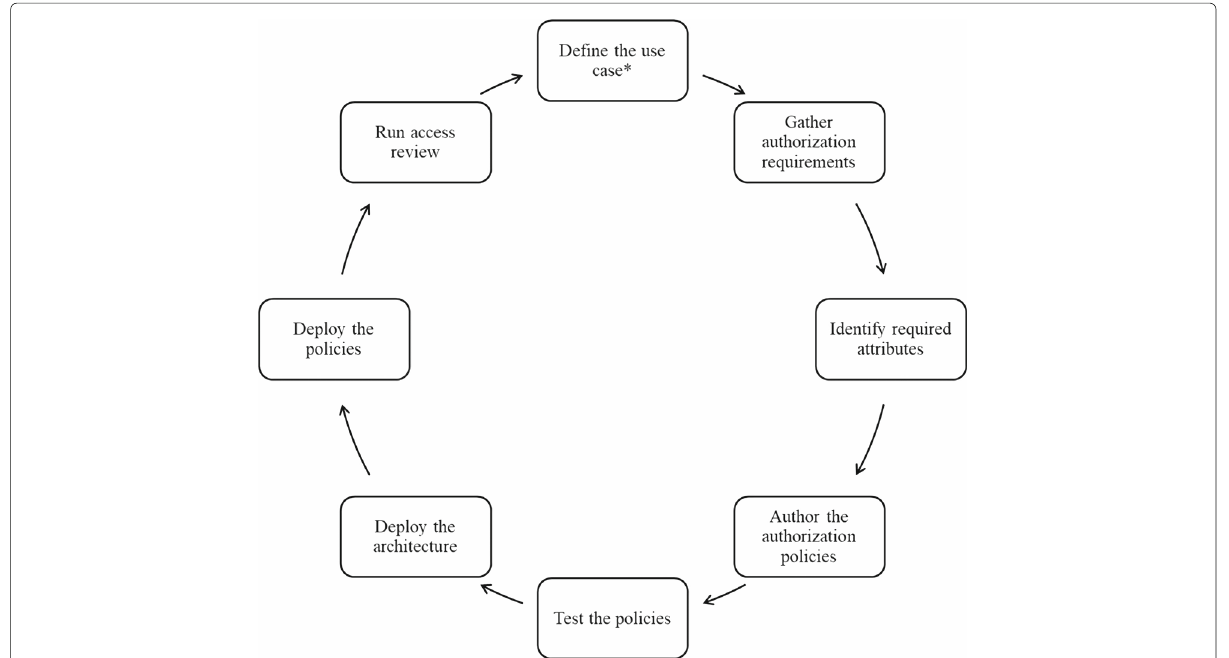
Fig. 1 The authorization policy lifecycle (adopted from Brossard et al. (2017)). *Asterisk marks the beginning of the